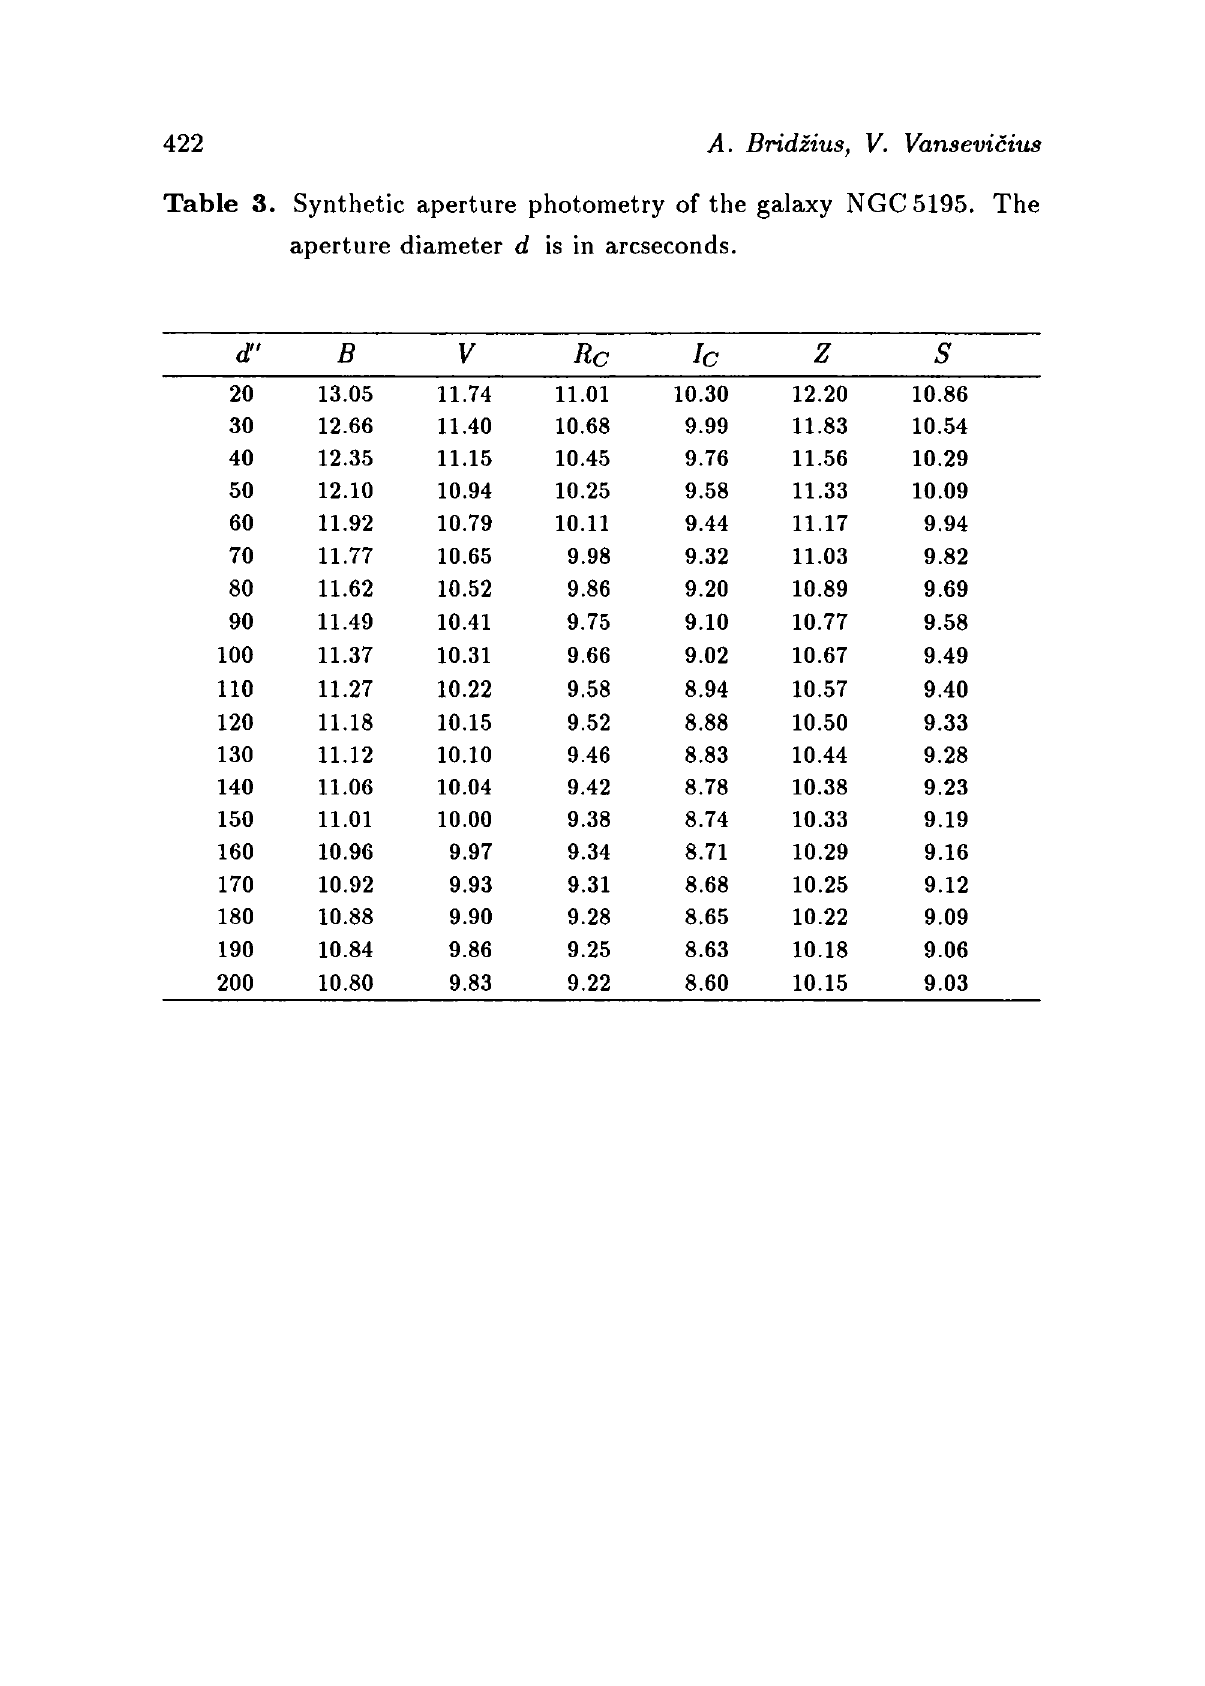
Table 3. Synthetic aperture photometry of the galaxy NGC 5195. The aperture diameter d is in